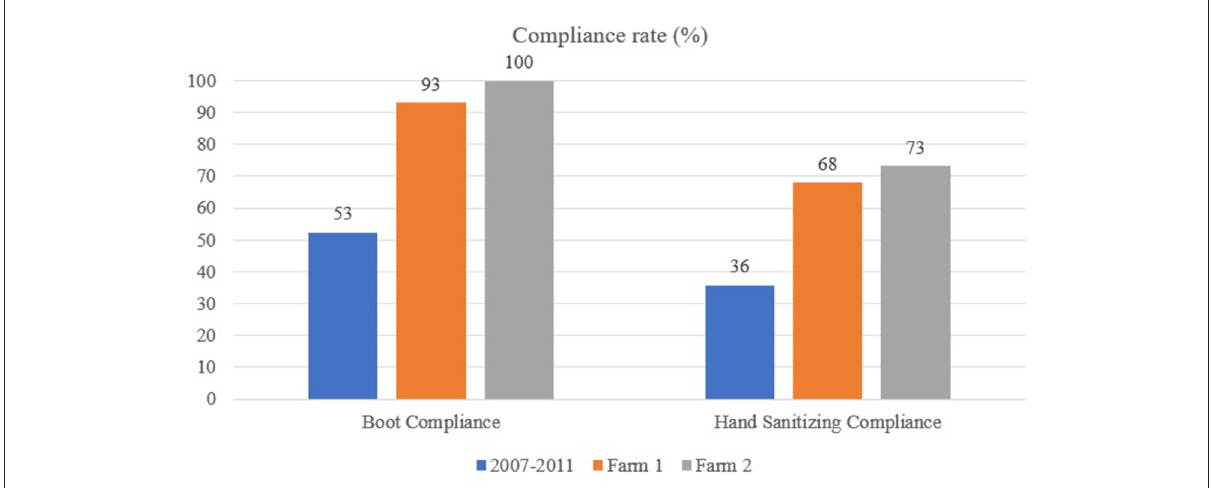
FIGURE2 Boot and hand sanitizing compliance at the farm level using the MediHandTrace system: comparison between Racicot et al. (21) study (performed between 2007 and 2011), egg layer farm (Farm 1) and broiler farm (Farm 2).